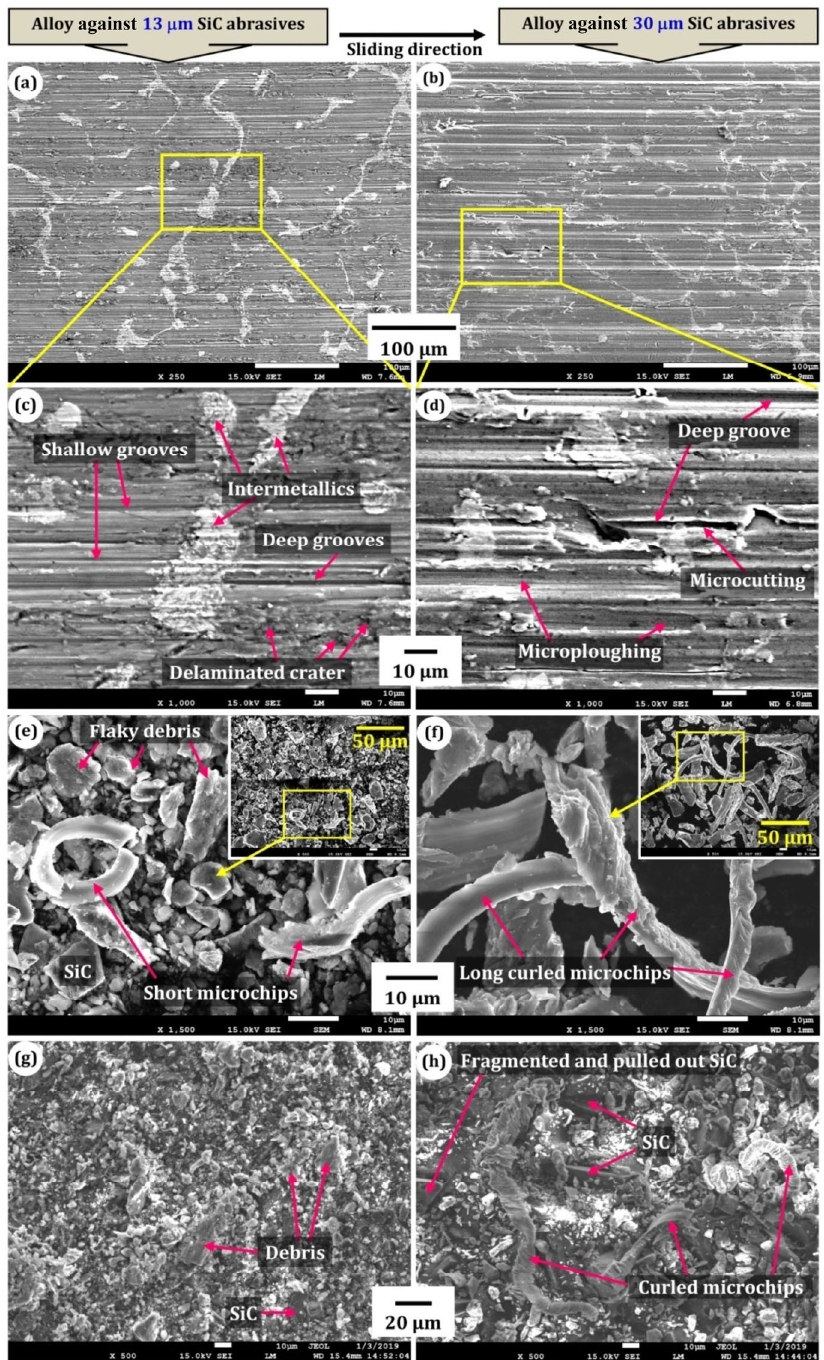
Fig. 3 FE SEM images illustrating the effects of size of SiC abrasives on the characteristics of abraded surfaces (a − d), generated debris (e–f), and abraded SiC emery papers (g–h) for unreinforced alloy under 40 N load, 20 m sliding distance, and 0.5 m·s − 1 sliding